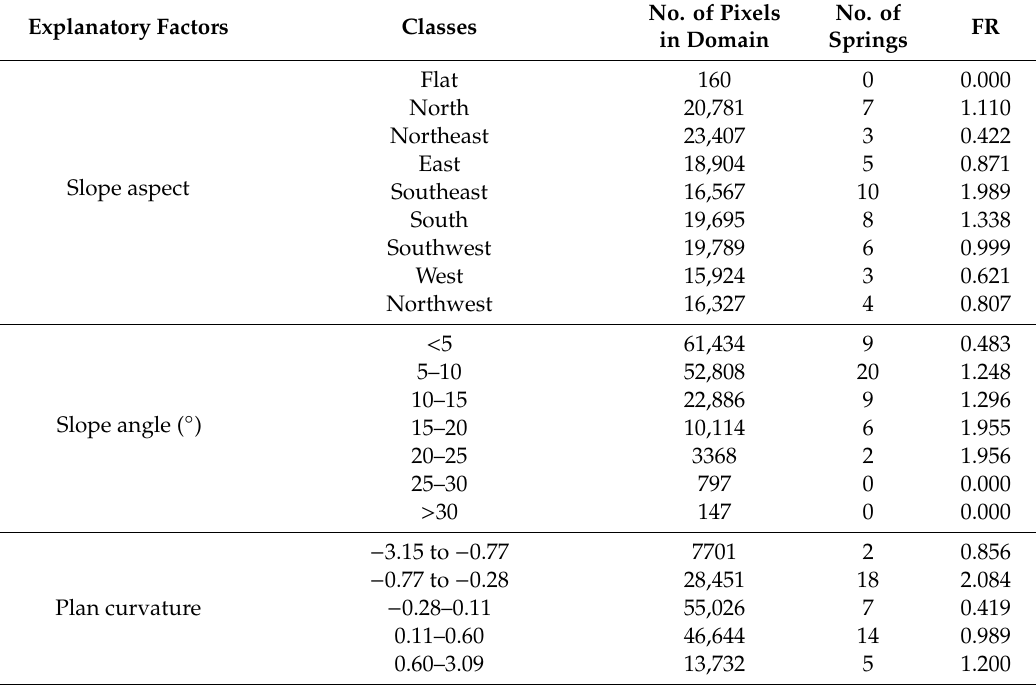
Table 3. Spatial relationship between springs and factors by FR